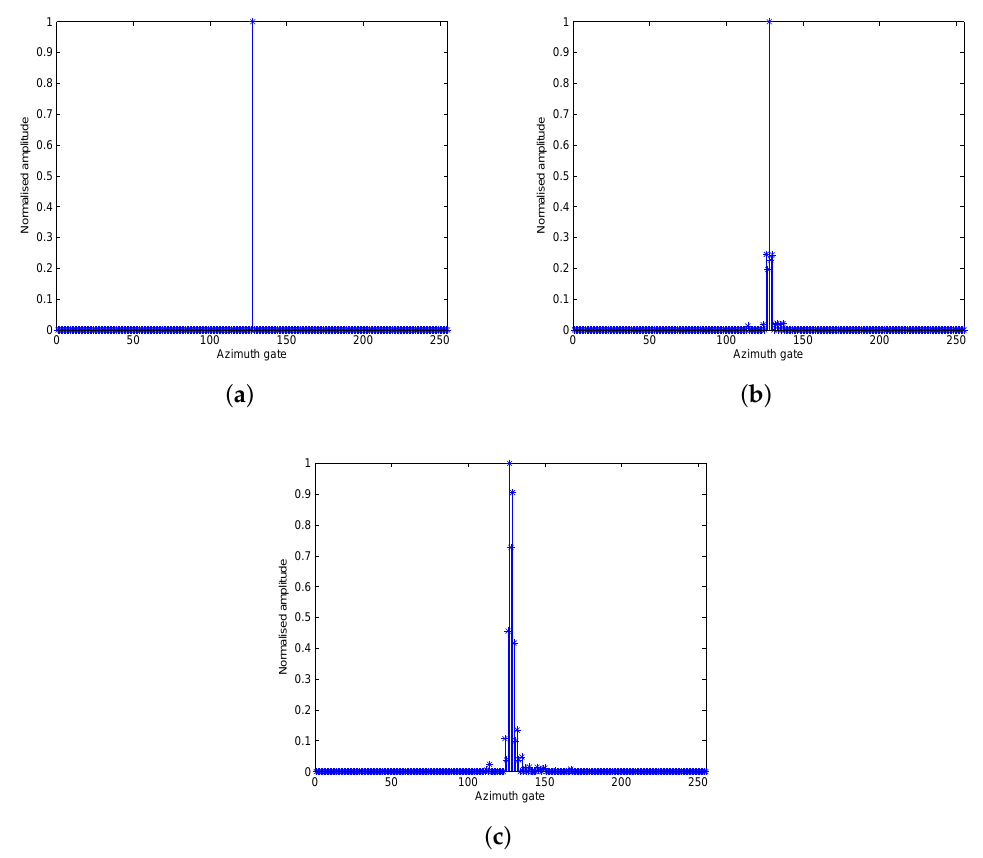
Figure 6. The influence of along-track velocity on SAR image: ( a ) v a = 0 m/s; ( b ) v a = 1 m/s; ( c ) v a = 2